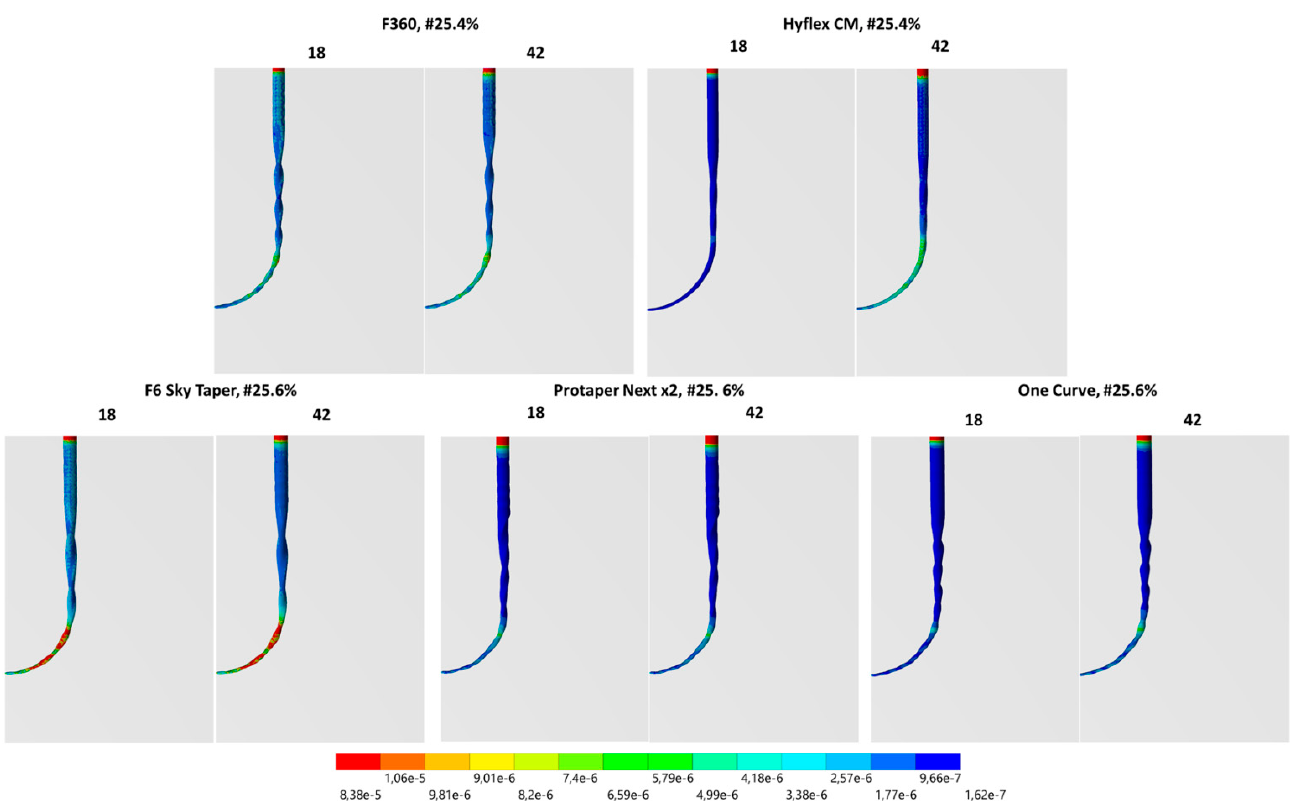
Figure 4. Strain distribution for each instrument according to the values of the elastic modulus of canal dentine (18 or 42 GPa).